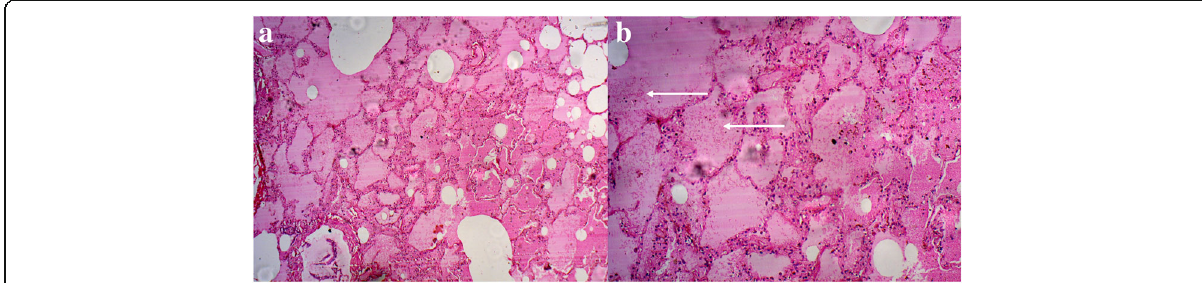
Fig. 2 Photomicrograph of lung, hematoxylin and eosin (H&E) stain (a:× 5; b:× 10); alveolar spaces are filled with edema fluid (pink homogenous proteinaceous material) indicated by an arrow